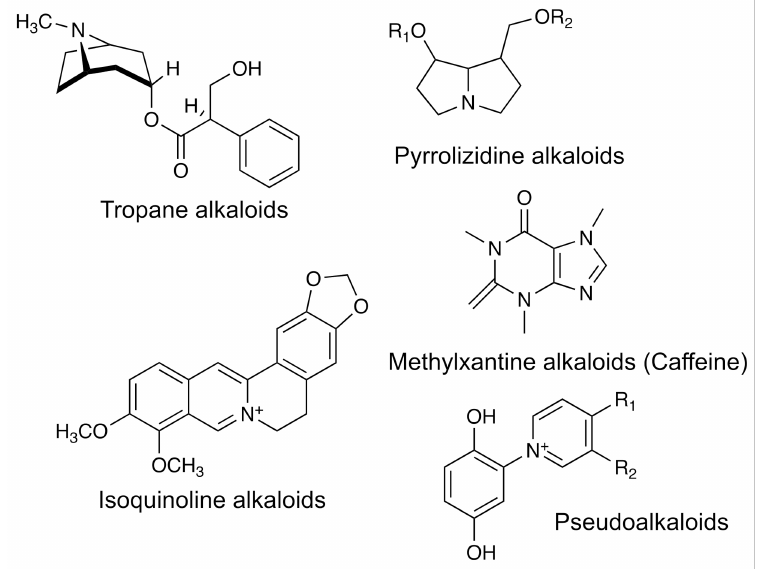
Figure 8. The chemical structure for some bioactive group of alkaloids. Furanocoumarins and naphthodianthrones